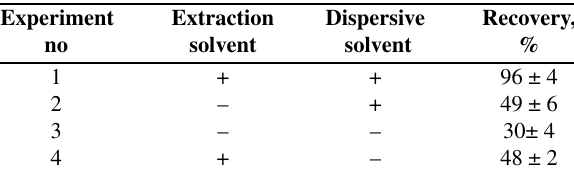
Table 2. Design matrix and the results of the 2 2 full factorial design